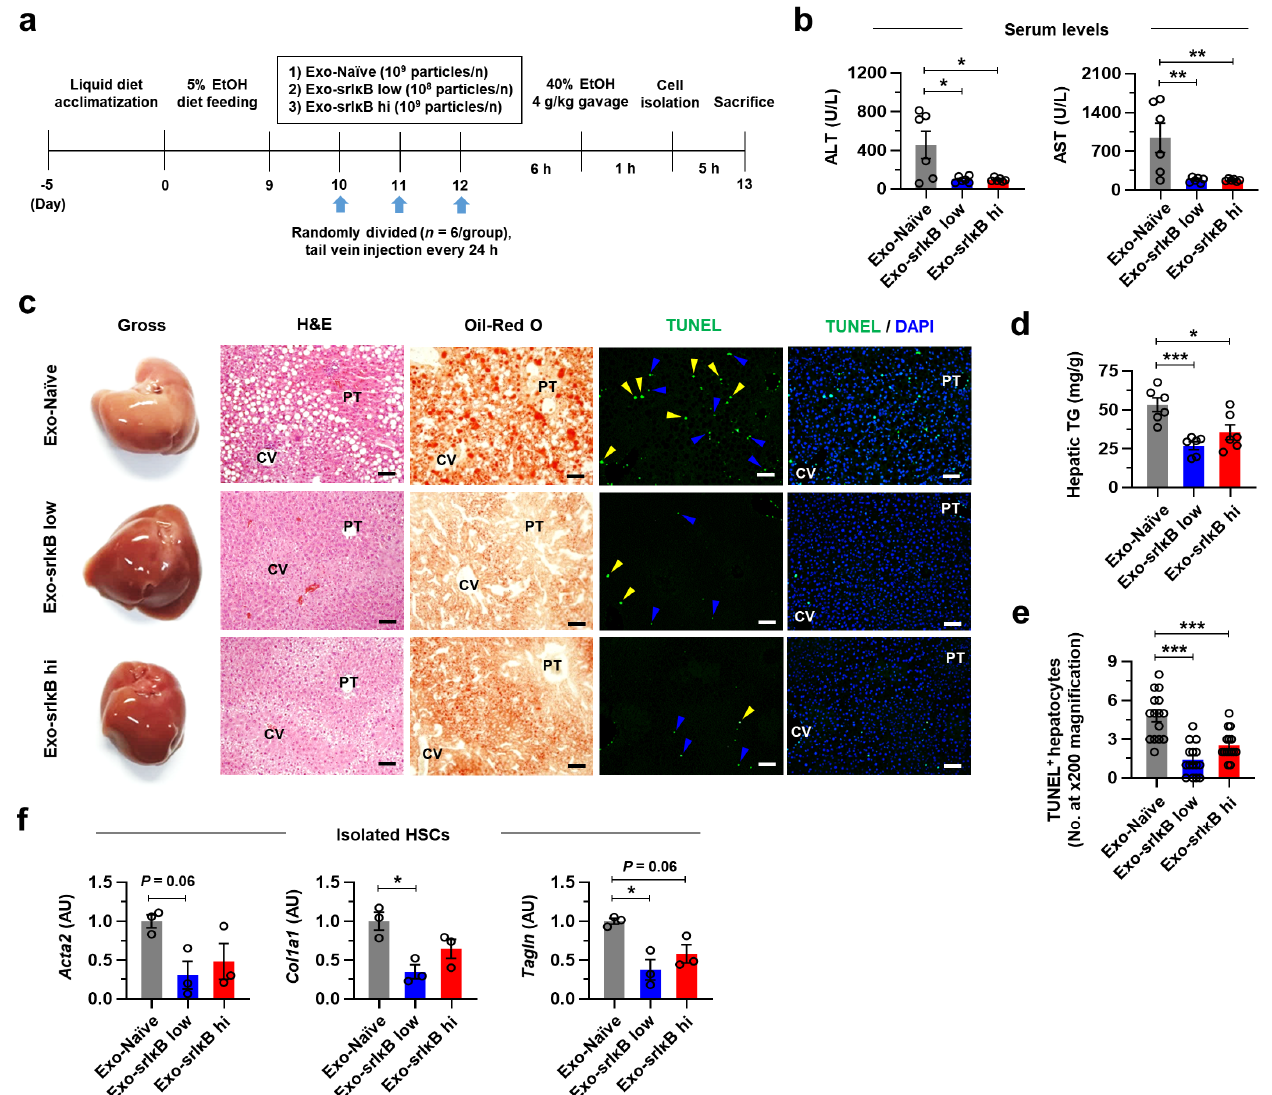
Figure 5. Three consecutive days of Exo-srI κ B injection mitigates ALI, AFL, and ALF in mice. ( a – f ) WT male mice were fed EtOH for nine days and randomly divided into Exo-Naïve (10 9 parti- cles/day/mouse), low dose of Exo-srI κ B (10 8 particles/day/mouse), or high dose of Exo-srI κ B (10 9 particles/day/mouse) groups ( n = 6 per group). An indicated dose of exosomes was intravenously injected every 24 hours for consecutive 3 days. After 6 h of the last injection, mice were given acute EtOH binge drinking (4 g kg − 1 of 40% EtOH gavage) and sacrificed after 6 h. ( a ) Schematic diagram of experiments. ( b ) Serum levels of ALT and AST were measured. ( c ) Representative gross